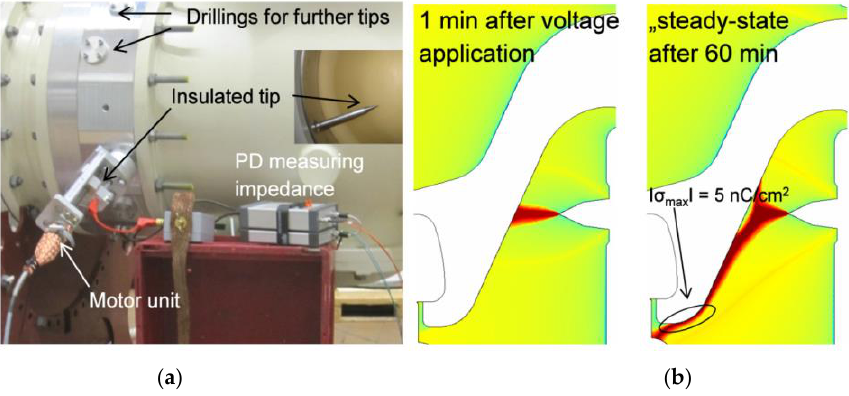
Figure 11. Illustrative exemple of ( a ) apparatus to charge insulators by partial discharges (PD) at an automatically moveable tip and ( b ) space charge distribution generated by PD from a sharp tip [57].